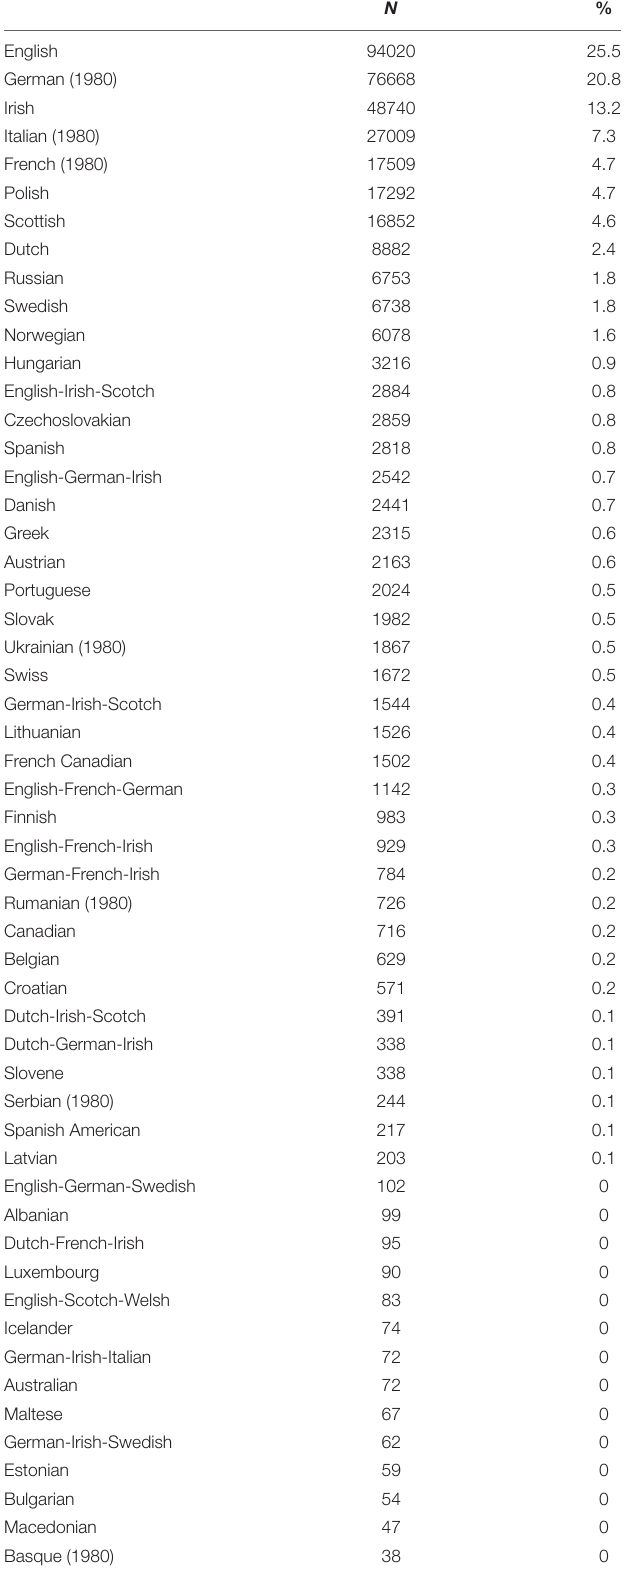
TABLE 1 | “Raw ancestry” of the women in our sample, counts, and